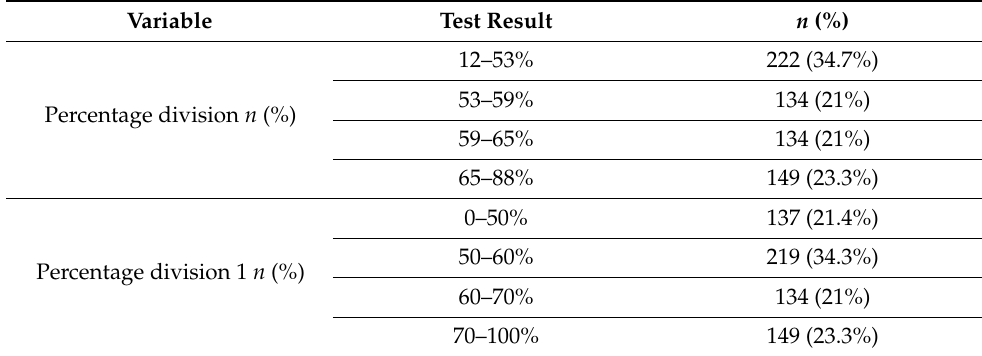
Table 2. Summary test results.